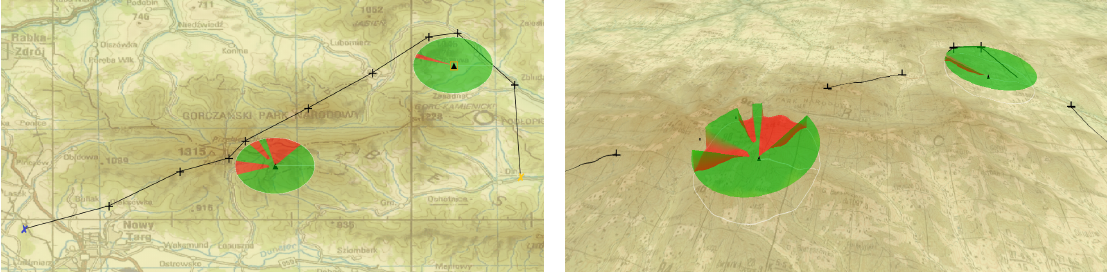
Figure 8. Example of a mission plan presented in 2D and 3D in high mountains.